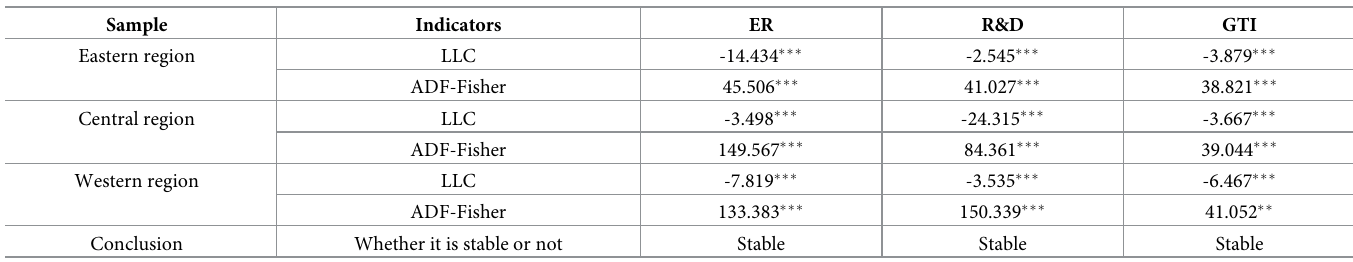
Table 2. Test results of panel smoothness. Sample